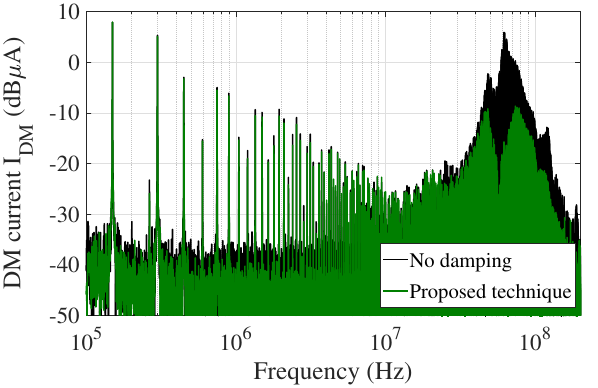
Figure 17. Spectra of the DM conducted current obtained from the time-domain voltages at the line impedance stabilization networks (LISNs) measurement port with no damping and with the proposed